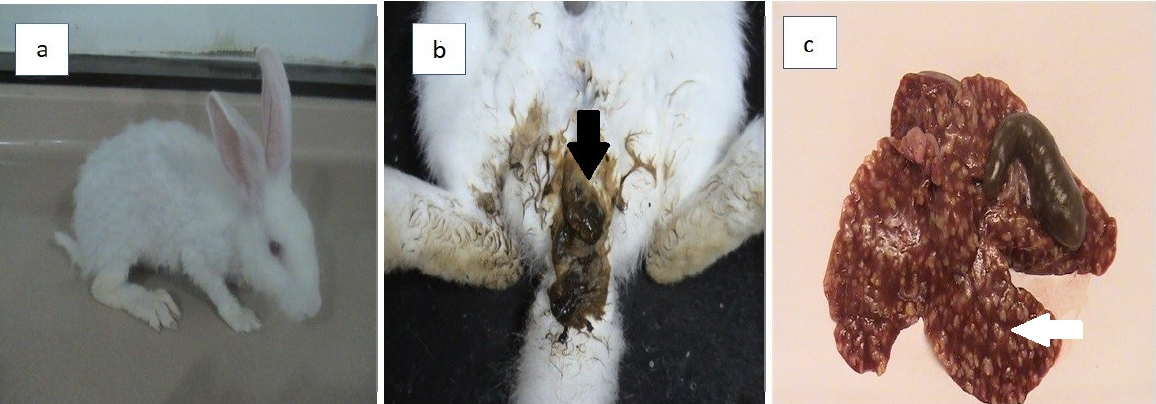
Figure 3. Domestic rabbits infected with hepatic coccidiosis (G2): ( a ) rough coat; ( b ) diarrhea (black arrow); ( c ) irregular yellowish–white nodules of variable sizes on the surface of the liver tissue (white arrow).